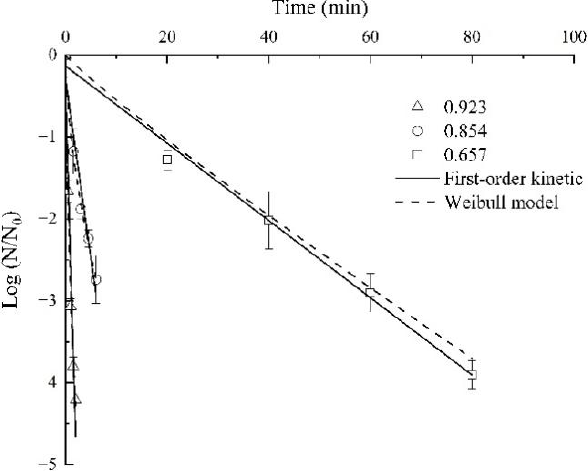
Figure 5. Survival curves of Aspergillus at 65 °C with a w of 0.657, 0.854 and 0.923, by fitting with first-order kinetic and Weibull models. Table 3. The re-estimated δ ’ -values at the mean of survival curves with the p -value fixed to 0.70. Moisture Content (% w.b.)